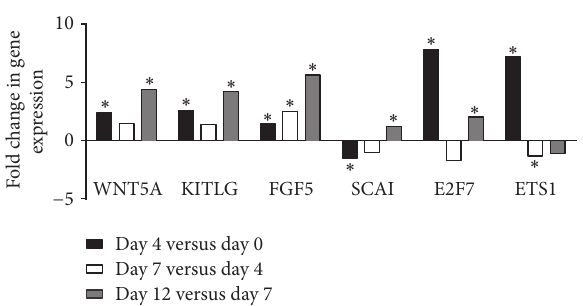
Figure 5: Fold changes in expression of genes related to cell cycle during the dedifferentiation process ( ∗ 𝑃 ≤ 0.05 ).